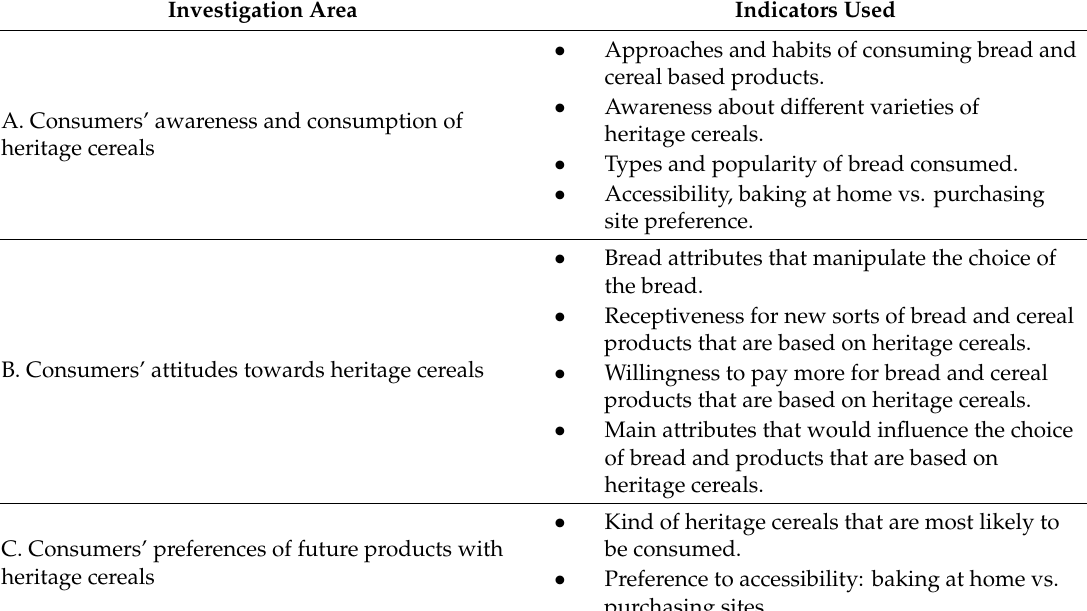
Table 1. Areas and questions covered in the web-based